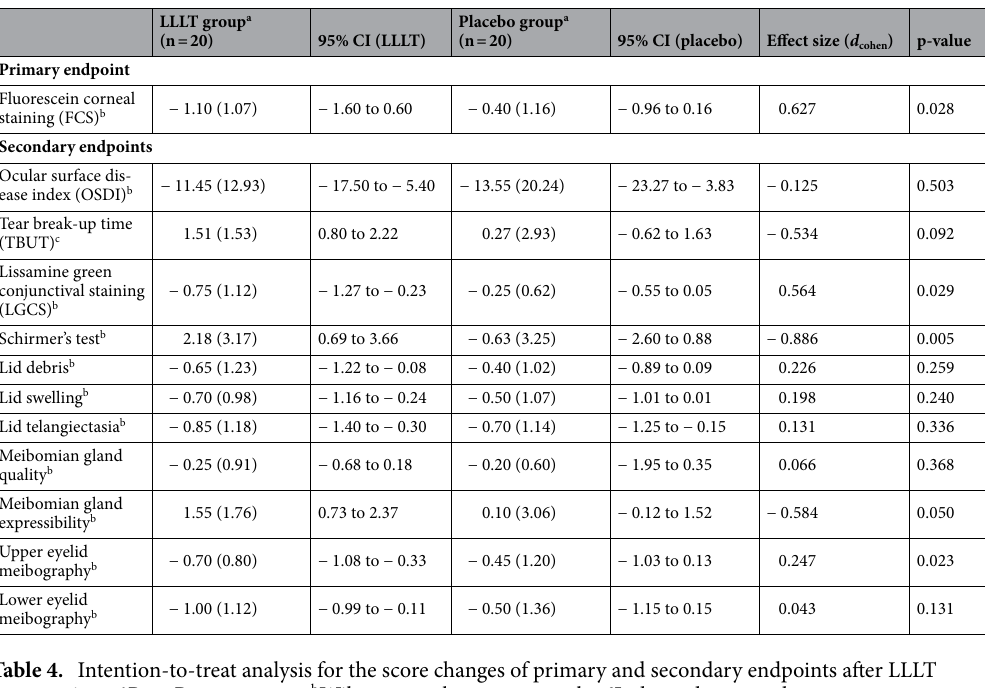
Table 4. Intention-to-treat analysis for the score changes of primary and secondary endpoints after LLLT interventions. a Post-Pre test scores. b Wilcoxon rank sum test results. c Independent sample t-test.